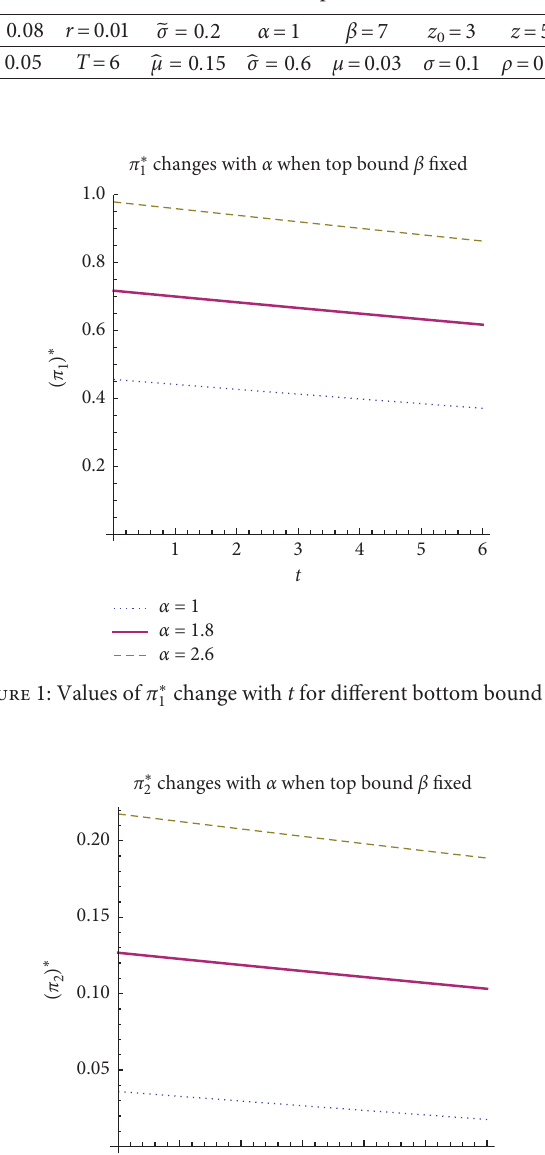
Table 1: Values of the parameters.